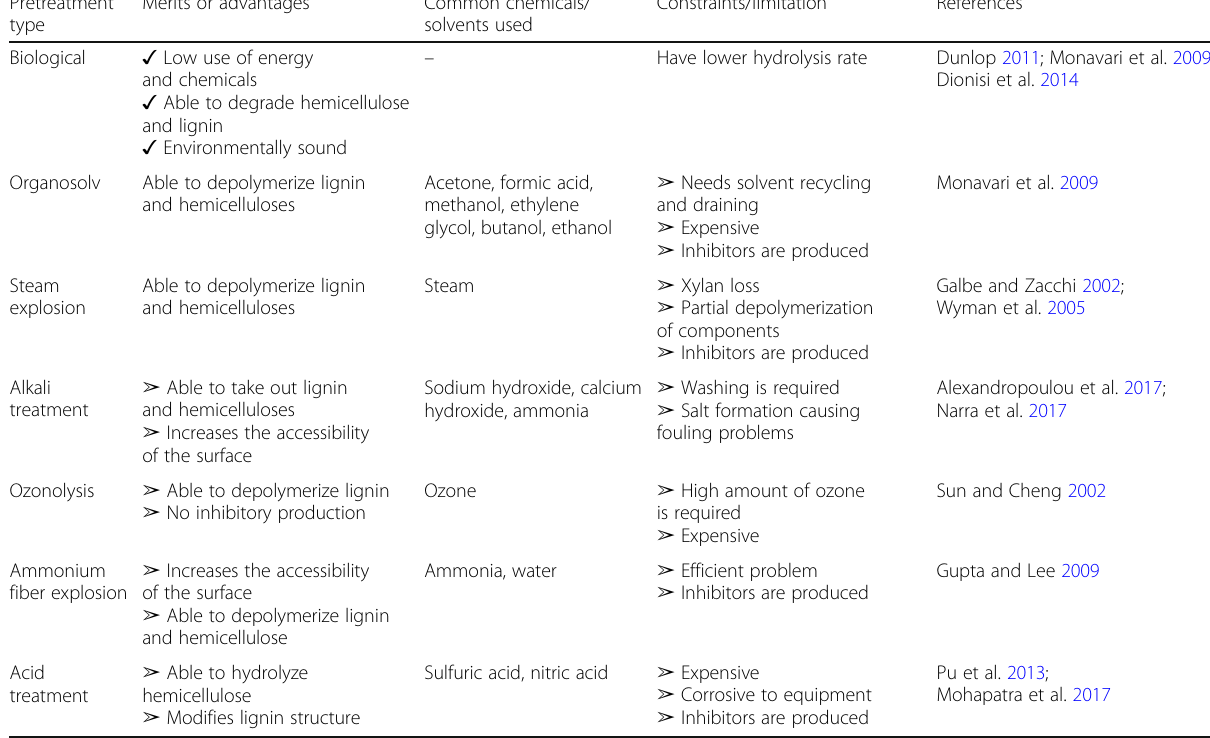
Table 2 Comparison of biological pretreatment with other pretreatment methods Pretreatment